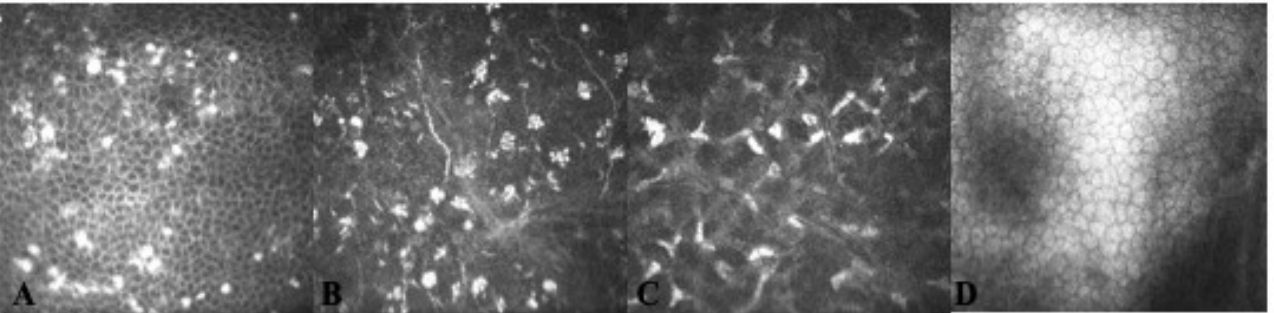
Figure 5. In vivo confocal microscopy (IVCM) of the cornea in a patient with belamaf keratopathy. ( A ): MECs appeared as hyper-reflective (at least predominantly) intracellular opacities present at the level of basal epithelium. ( B ): Hyperreflective lesions arranged in clusters, resembling “pseudo- rosette” pattern at the level of sub-basal nerve plexus. ( C ): Activated keratocyte network detected in the anterior stroma. ( D ): Normal endothelial cells morphology.